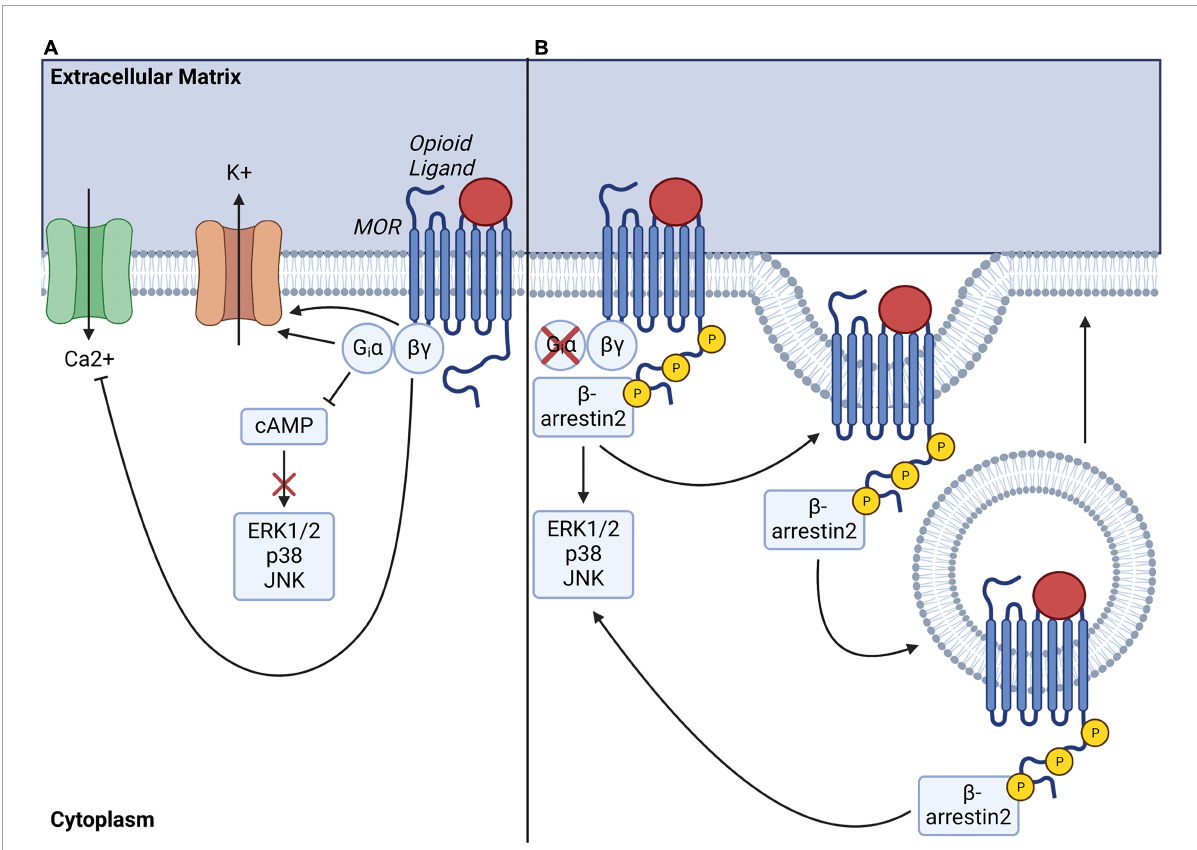
FIGURE1 Mu-opioid receptor (MOR) signaling transduction pathways, internalization, and recycling. (A) Ligand-activation of MOR activates G α i / o -induced inhibition of adenylate cyclase, resulting in decreased intracellular cAMP levels and depleted downstream signaling. G α i / o also serves to activate G protein gated inwardly rectifying potassium channels, leading to efflux of potassium ions while β γ heterodimers simultaneously perturb calcium influx by inhibiting voltage gated calcium channels, overall inhibiting intracellular signaling and cellular activity. (B) Ligand-activation of MOR also eventually leads to phosphorylation of MOR c-terminal tail by G protein receptor kinases (GRKs), which enables docking of β -arrestin2 and initiates MOR endocytosis for further receptor degradation or recycling. Note that recruitment of β -arrestin2 can also drive activation of downstream signaling effectors, including ERK, p38 or JNK